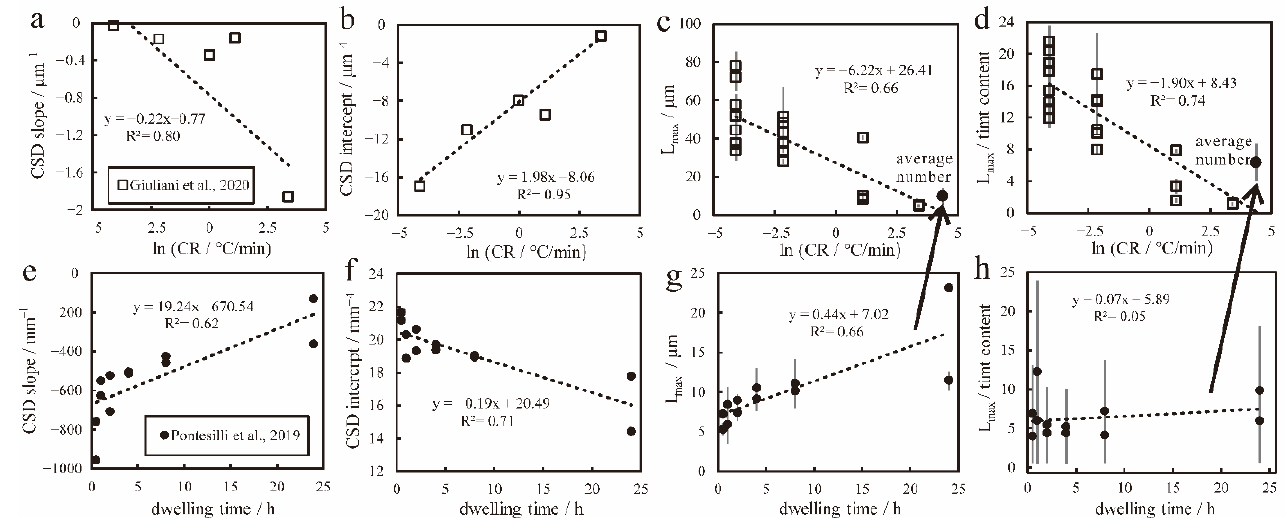
Figure 10. The relationship between quantitative textural parameters and cooling rate [43] and dwelling time [34]. ( a ): The relationship between ln (cooling rate (CR)) and CSD slope; ( b ): the relationship between ln (CR) and CSD intercept; ( c ): the relationship between ln (CR) and L max (maximum particle size); ( d ): the relationship between ln (CR) and L max /timt content (ratio of maximum particle size to area abundance); ( e ): the relationship between dwelling time and CSD slope; ( f ): the relationship between dwelling time and CSD intercept; ( g ): the relationship between dwelling time and L max ; ( h ): the relationship between dwelling time and the L max /timt content. L max is the average of the ten largest particles [34]; L max is the average of the four largest particles [43]. The fitting line is for all